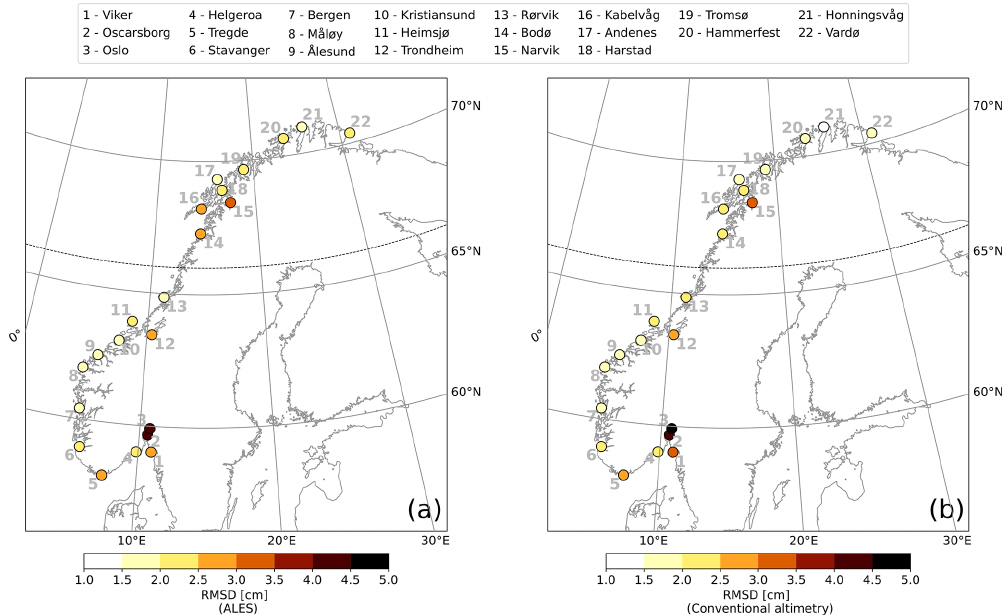
Figure C2. At each tide gauge location, RMSD of the detrended, deseasoned monthly mean SLA estimated from the ALES-reprocessed satellite altimetry dataset and from the tide gauge (a) , as well as from the conventional altimetry dataset and from the tide gauge (b) . The black dashed line indicates the 66 ◦ N parallel.